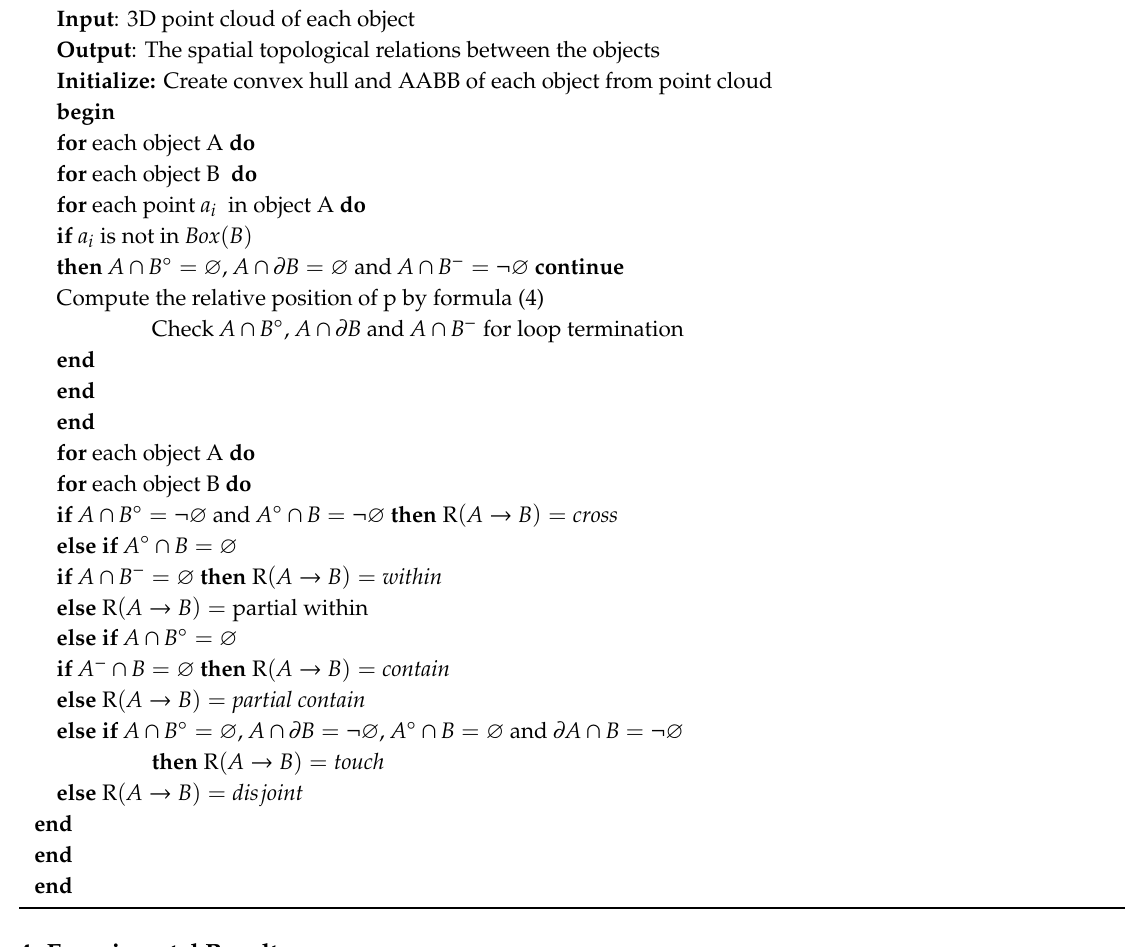
Algorithm 1. Spatial Topological Relation Analysis